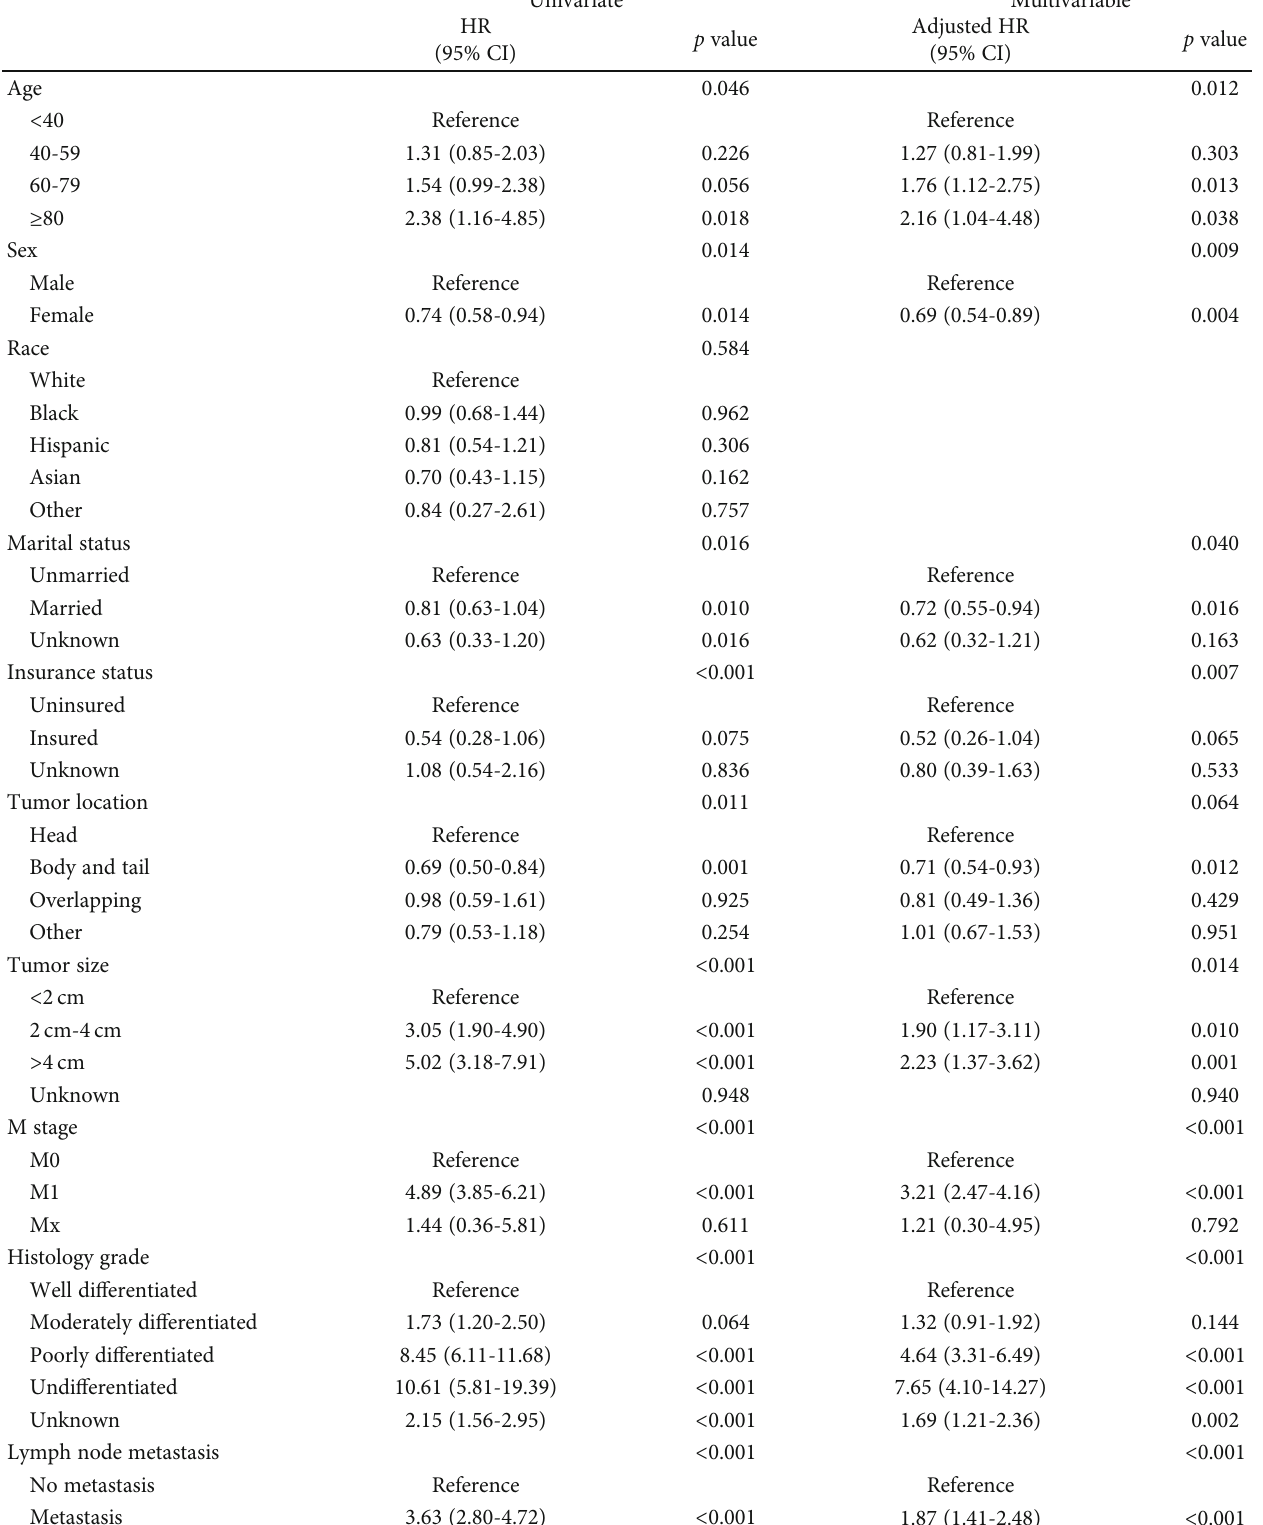
Table 4: Results of univariate and multivariable analysis for disease-speci fi c survival in the entire study